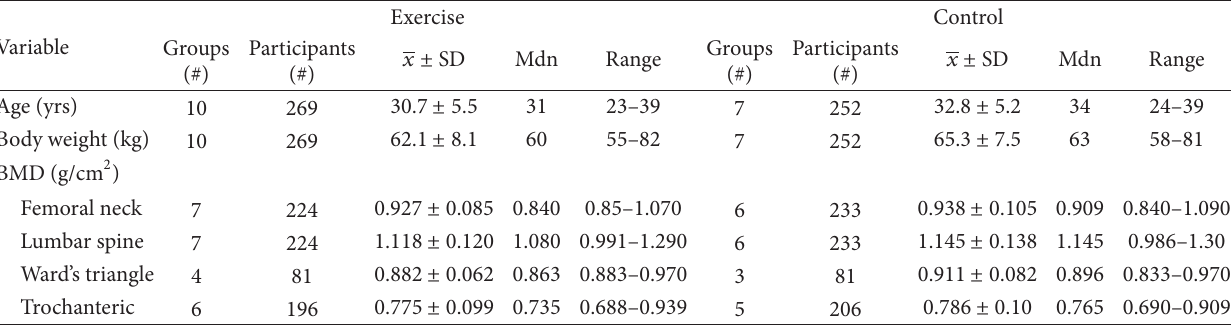
T 2: Initial physical characteristics of